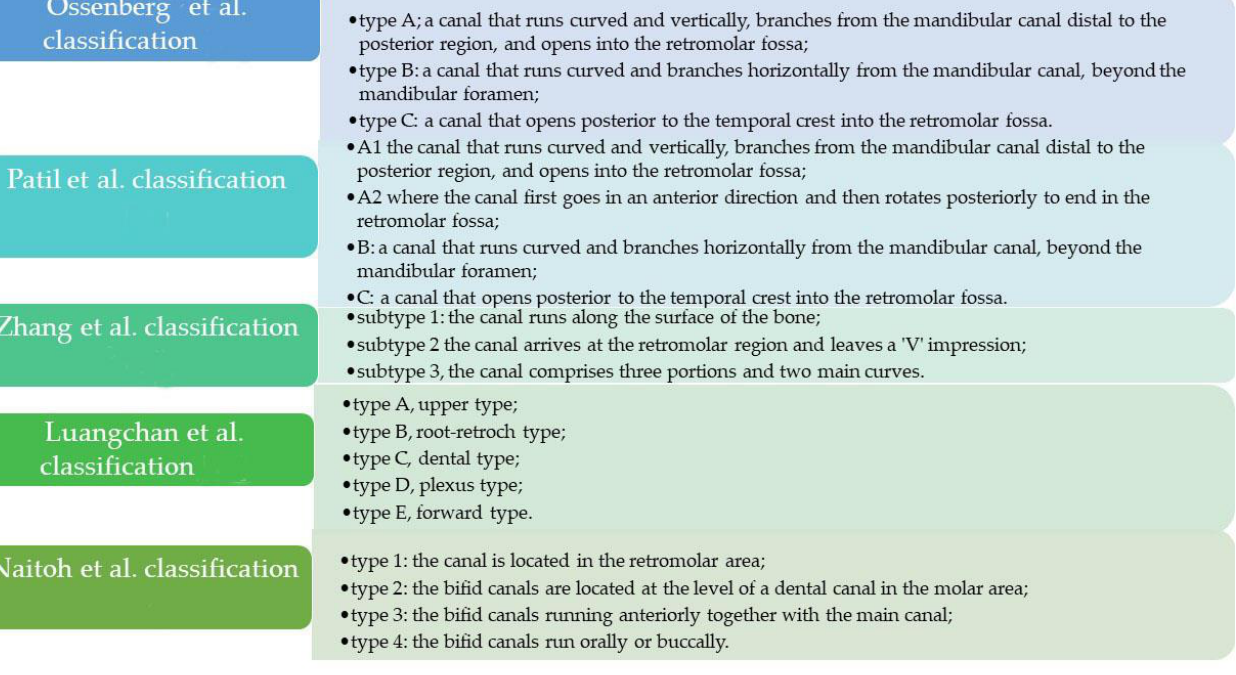
Figure 1. Diagram of the different classifications [12,13,15–17]. Ossenberg [12] and von Arx et al. [14] proposed to classify bifid and trifid canals into three categories: type A includes a canal that runs curved and vertically, branches from the mandibular canal distal to the posterior region, and opens into the retromolar fossa; type B includes a canal that runs curved and branches horizontally from the mandibular canal, beyond the mandibular foramen; and type C includes a canal that opens posterior to the temporal crest into the retromolar fossa. Patil et al. further divided one of these anomalies into two variants [13]. Specifically, they grouped type A of Ossenberg’s classification into two variants: A1, where the canal goes posteriorly and superiorly and opens into the retromolar fossa, and A2, where the canal first goes in an anterior direction and then rotates posteriorly, to end in the retromolar fossa. Zhang et al. proposed three subgroups: subtype 1, which runs along the surface of the bone; subtype 2, which arrives at the retromolar region and leaves a V impression; and